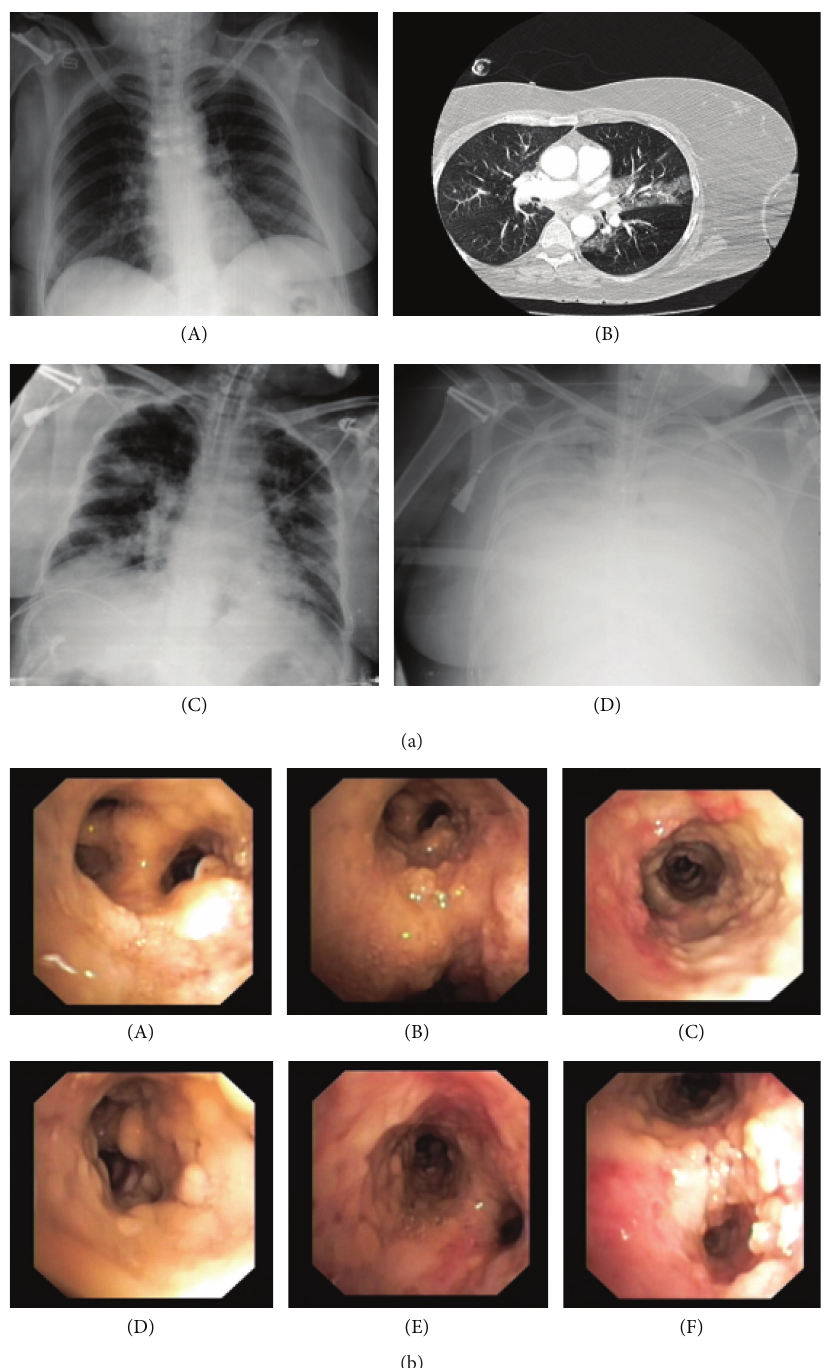
Figure 1: Radiological and bronchoscopic findings. (a) Radiological findings. (A) Chest radiography (CRx) at hospital admission (day 1). (B) Computed tomography revealing small lingula consolidation (day 2). (C) CRx at ICU admission with new bilateral infiltrates (day 3). (D) CRx after 24 h of ICU admittance showing bilateral atelectasis (day 4). (b) Bronchoscopic findings. (A) Necrotic detritus and pseudomembrane in the right upper lobe. (B) Right upper lobe and right carina with an extensive deposit of necrotic material. Bronchoscopic biopsy was performed and revealed the presence of fungus with hyphae suggestive of Aspergillus . (C) Involvement of intermediate bronchus. (D) The orifice of bronchus in the culmen was not visible because of a large quantity of necrotic material. Bronchial wash fluid revealed the presence of Aspergillus . (E) Necrotic detritus and pseudomembrane in the left upper lobe. (F) Involvement of culmen, left carina, and